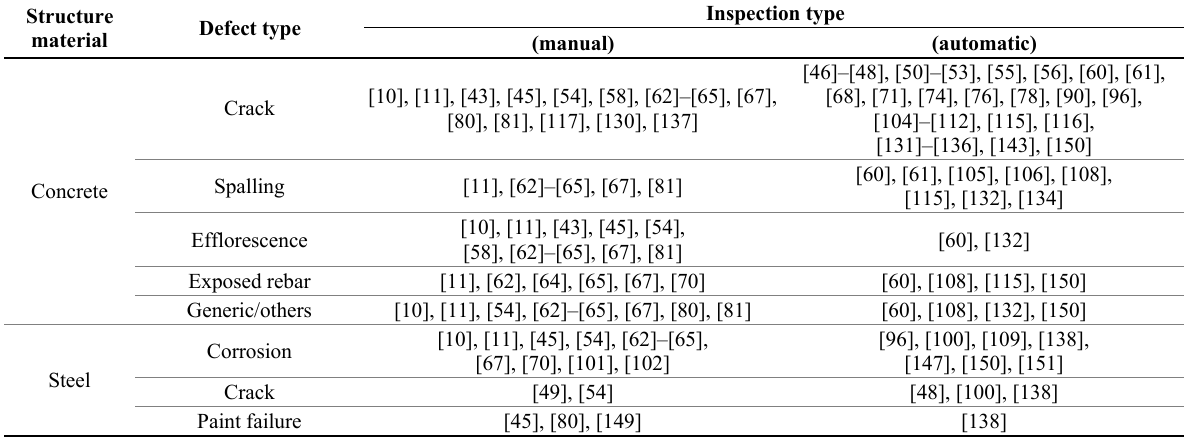
Table 3. Structural defect detection researches in UAV-based bridge visual inspection